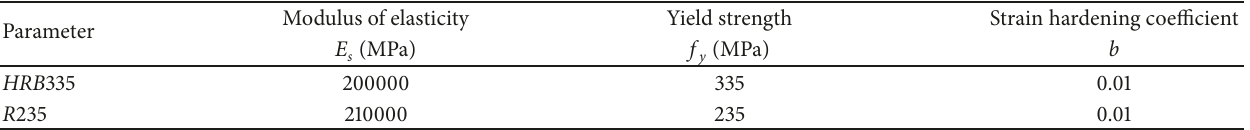
Figure 7: Carbonation rate of concrete. Table 1: Material parameters of